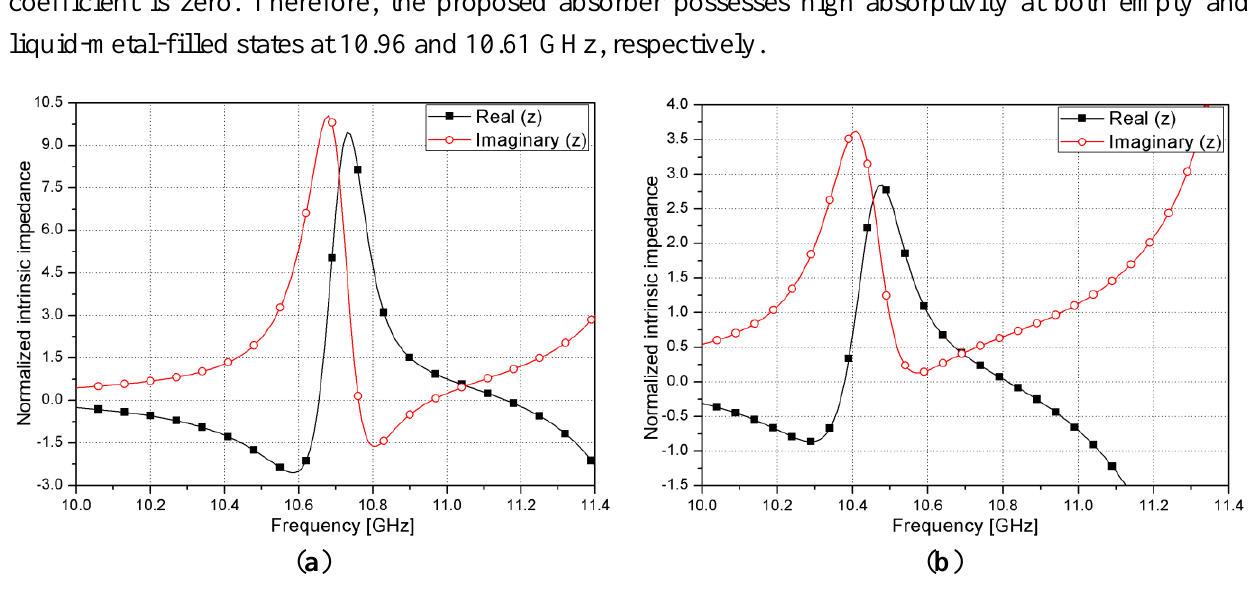
Figure 5. Normalized complex impedance of proposed metamaterial absorber with ( a ) Empty channels; ( b ) Liquid metal-filled